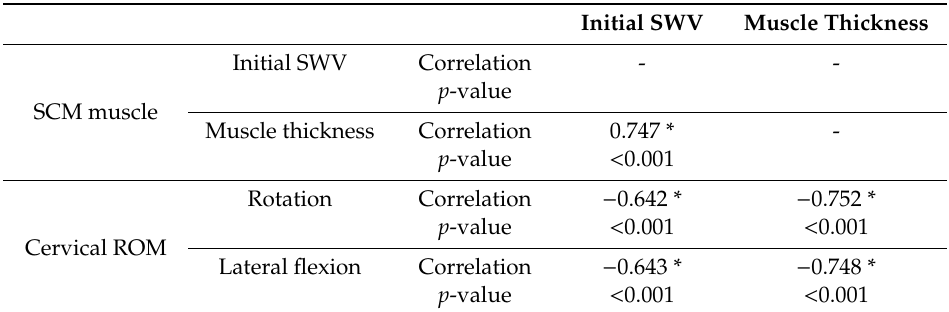
Table 3. Correlations among initial shear-wave velocity, thickness of sternocleidomastoid muscle, and cervical range of motion.